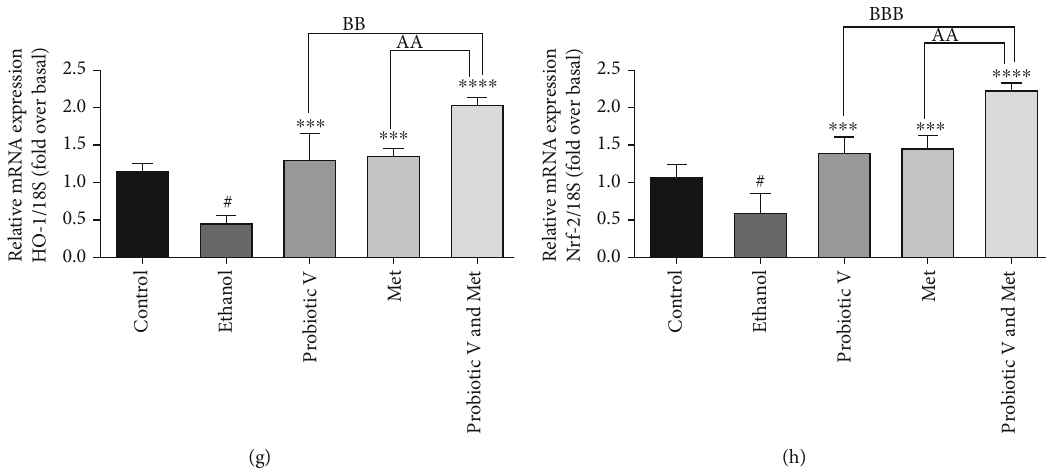
Figure 10: qRT-PCR analysis results of (a) CYP2E1, (b) IL-1 β , (c) iNOS, (d) TLR-4, (e) TNF- α , (f) IL-10, (g) HO-1, and (h) Nrf-2 genes in ethanol-exposed HepG2 cells alone and along with probiotic V and Met alone or in combination treatment for 48h. The gene expression levels were calculated after stabilizing against 18S rRNA in every sample and are presented as relative mRNA expression units. Values represent the mean ± SD of three individual experiments. Statistical signi fi cance was assessed by one-way ANOVA followed by Tukey post hoc test. Statistical analysis: # p < 0 : 05 , ## p < 0 : 01 , and #### p < 0 : 0001 compared with control group; ∗ p < 0 : 05 , ∗∗ p < 0 : 01 , ∗∗∗ p < 0 : 001 , and ∗∗∗∗ p < 0 : 0001 compared with ethanol group; A,B p < 0 : 05 , AA,BB p < 0 : 01 , AAA,BBB p < 0 : 001 , and AAAA,BBBB p < 0 : 0001 compared with probiotic V and Met combinatorial